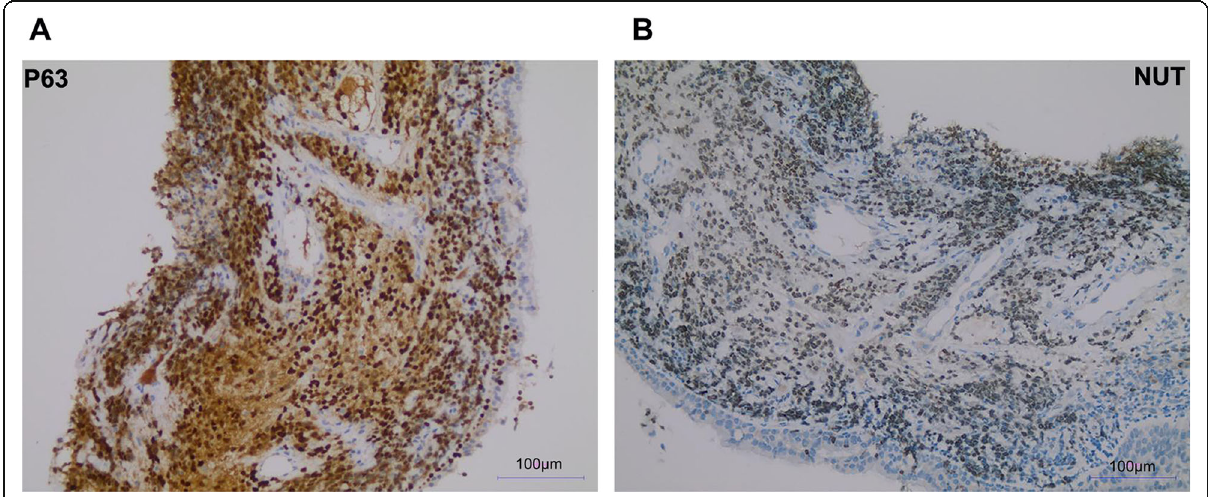
Fig. 1 IHC staing showed markedly positive. A: P63 was the positive one which supported squamous cell carcinoma. B: IHC staing with NUT protein showed obviously positive. Scale bar = 100 μ